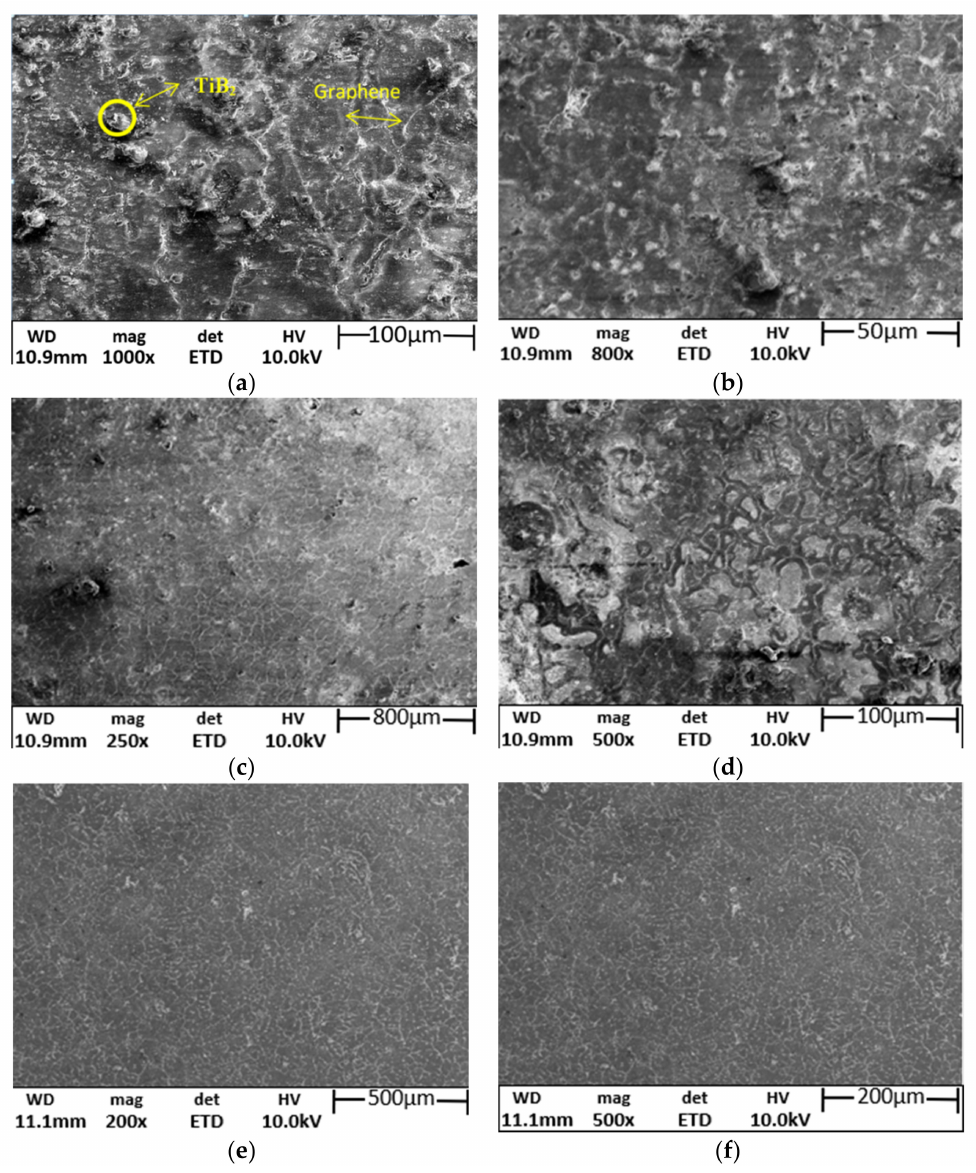
Figure 3. SEM images of AM hybrid composite ( a ) Reinforced particles, ( b ) Distribution of graphene particles, ( c ) Distribution of TiB2 particles, ( d ) Improved thickness of grain boundary, ( e ) Finer grain development, ( f ) Magnified version of finer